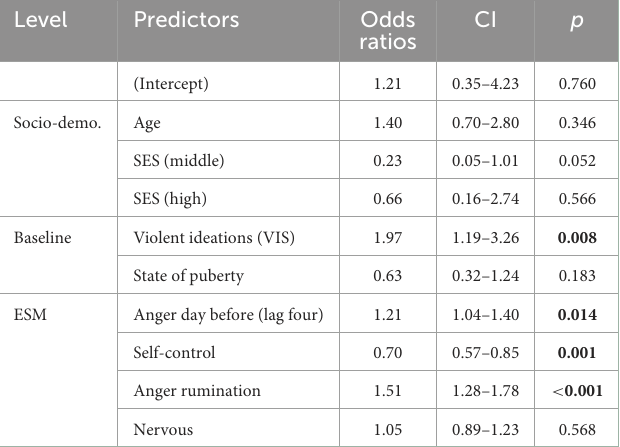
TABLE 2 Generalized linear mixed-effects model on aggressive